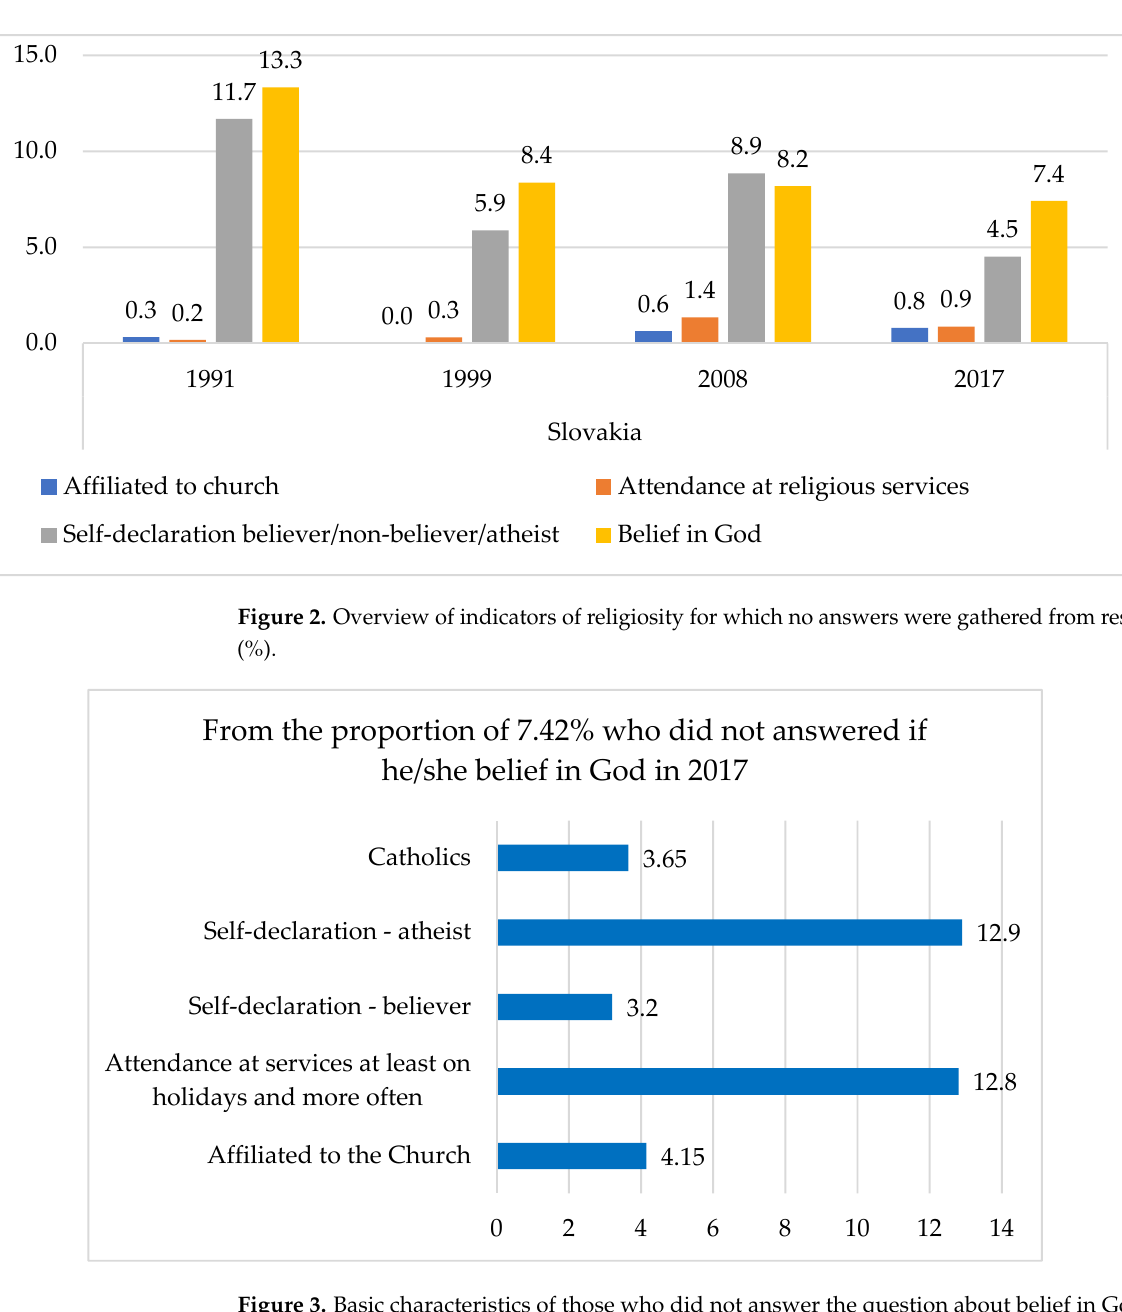
Figure 3. Basic characteristics of those who did not answer the question about belief in God in 2017 (%).